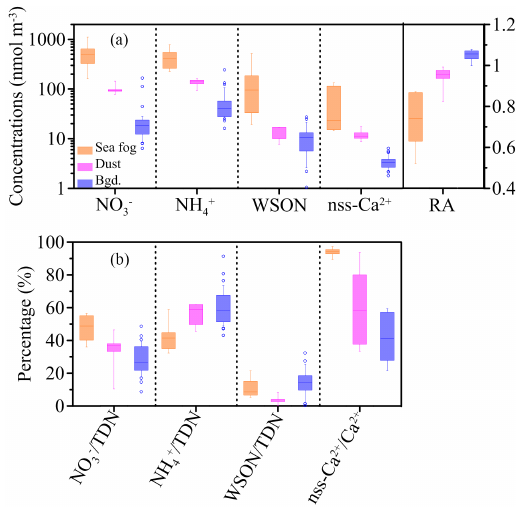
Figure 6. Box plots for (a) concentrations of NO − and nss-Ca 2 + , and RA, and (b) fractions of nitrogen species in total dissolved nitrogen and proportion of nss-Ca 2 + in Ca 2 + , in sea-fog- modified, dust and background aerosols. The large boxes represent the interquartile range from the 25th to 75th percentile. The line inside the box indicates the median value. The whiskers extend up- ward to the 90th and downward to the 10th